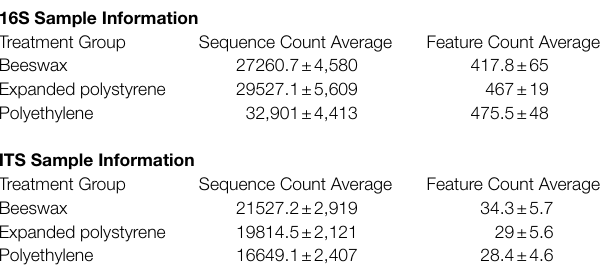
TABLE 1 | Count average’s for sequences and features from 16S and ITS